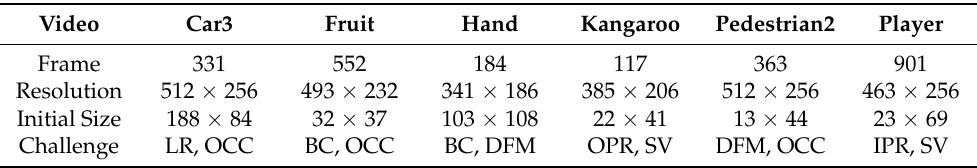
Table 1. The details of the experimental videos.